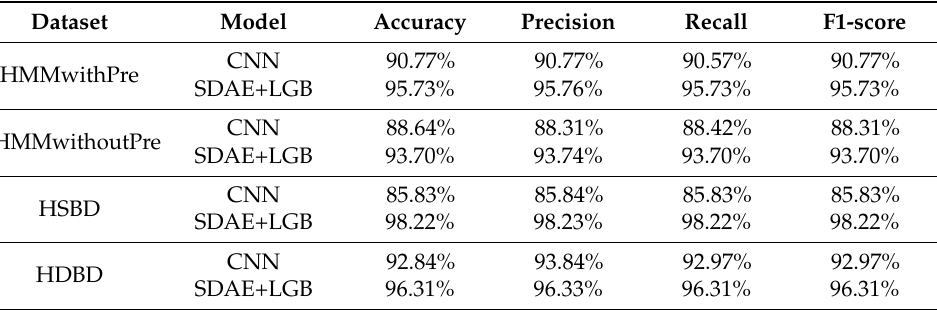
Table 11. The evaluation score of CNN on four datasets.